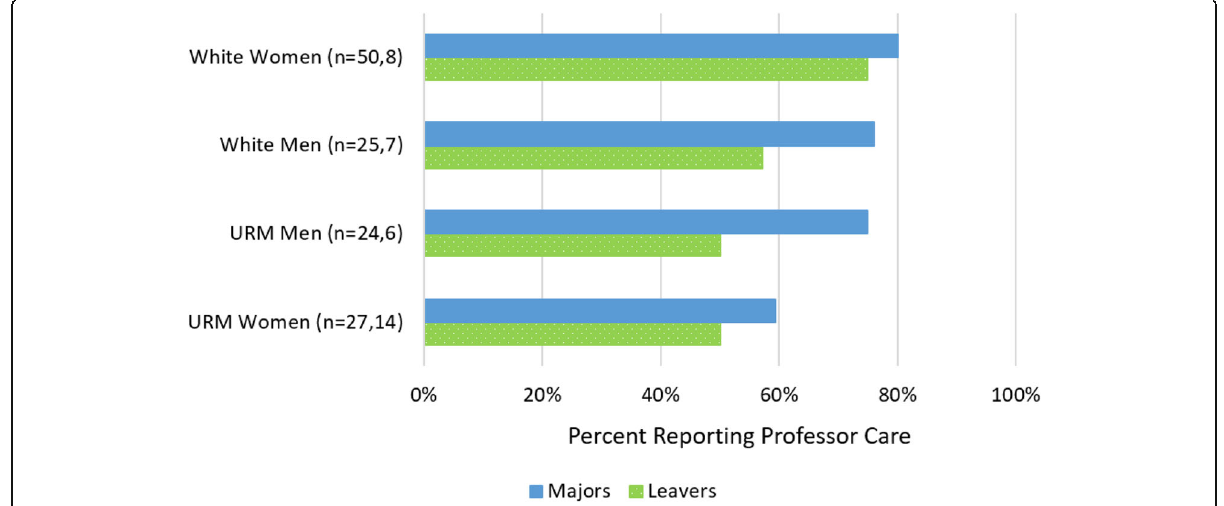
Fig. 2 Perceived professor care by major status, race, and gender. N values are report for majors and leavers,